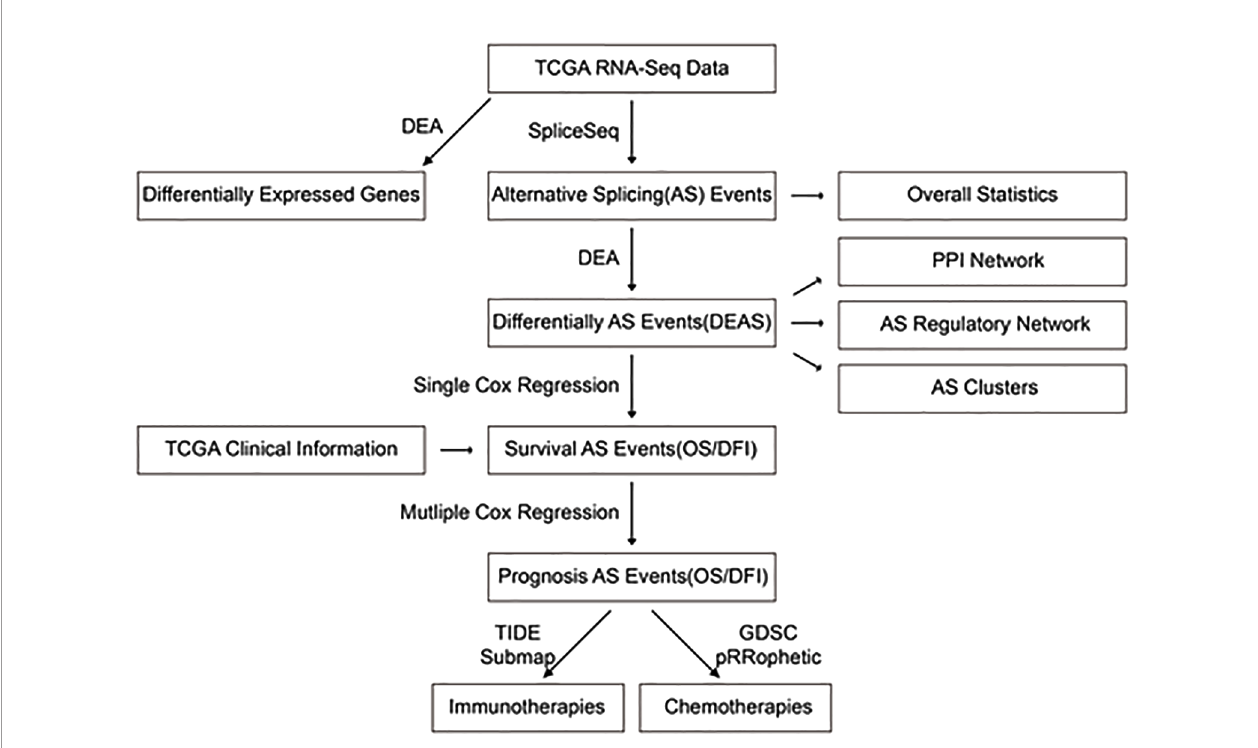
FIGURE 2 | Overall framework of the